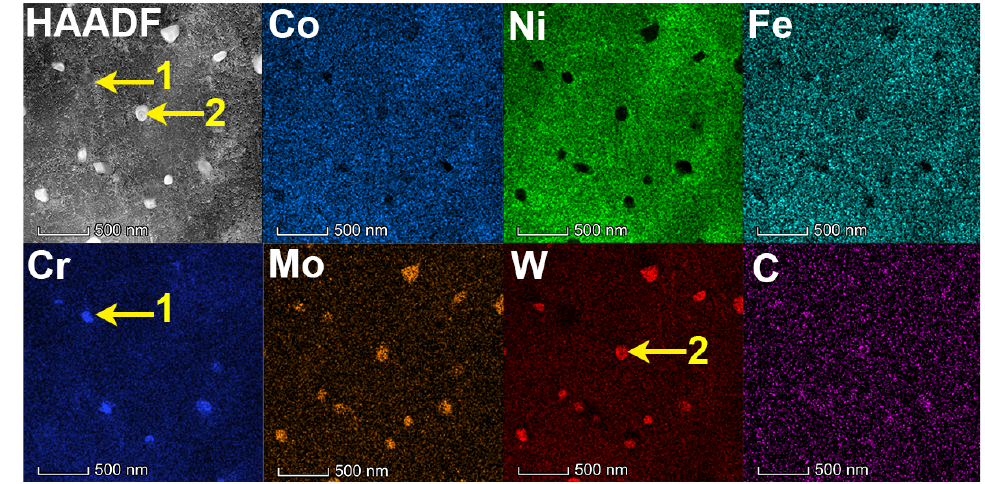
Figure 9. Elements mapping of the CRHA.